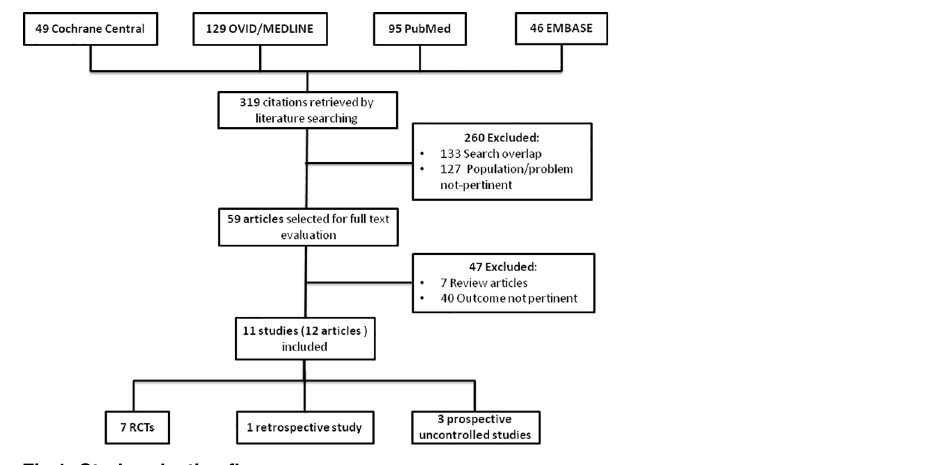
Fig 1. Study selection